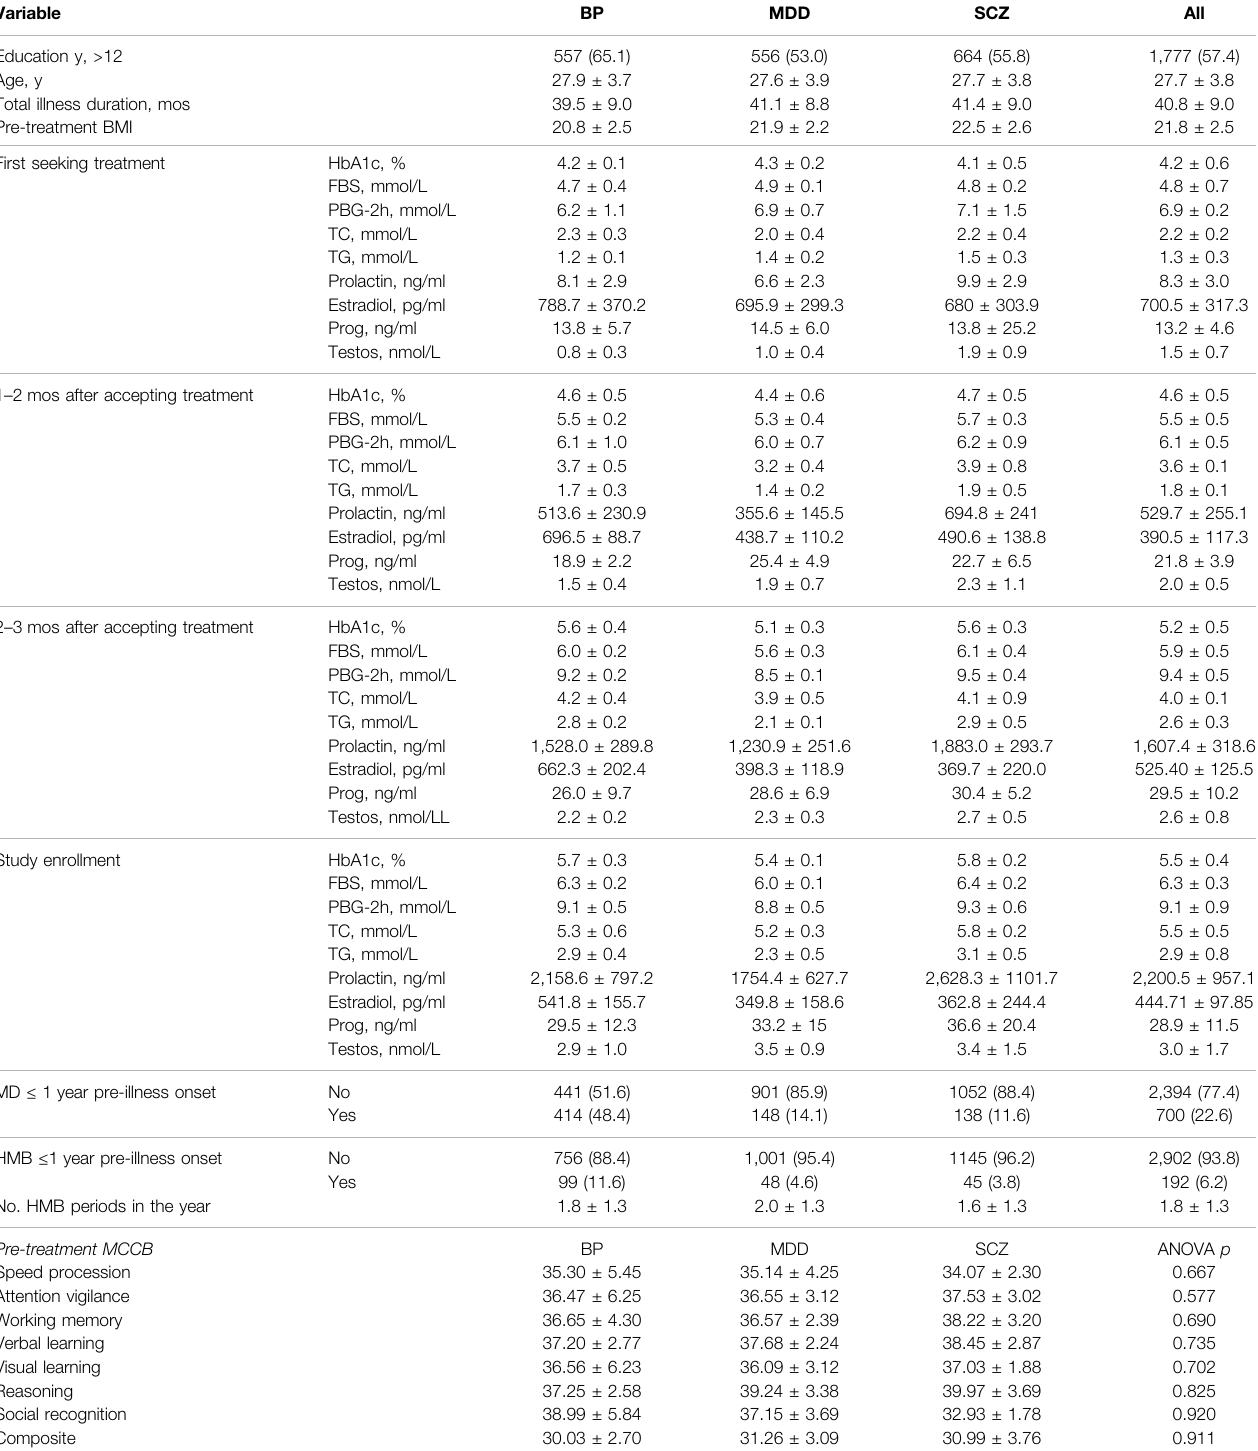
TABLE1| Characteristicsofthetotalsample( N =3,094)andthebipolardisorder(BP; N =855),majordepressivedisorder(MDD; N =2,049),andschizophrenia(SCZ; N =1, 190) groups.